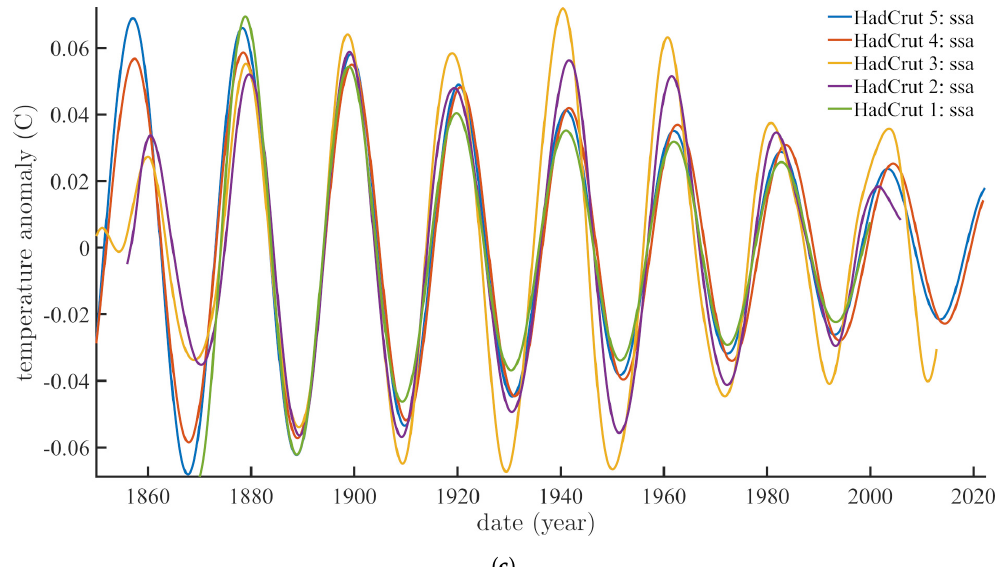
Figure 8. Trend, one year and sixty years components extracted from HadCrut curves. ( a ) The first iSSA components (trends) of the five HadCrut Center temperature series introduced in Section 2.1, and their median shown in black among the 5 trends and alone above as an inset. ( b ) Annual iSSA components of the same series as in Figure 8a. ( c ) Sixty year iSSA components of the same series as in Figure